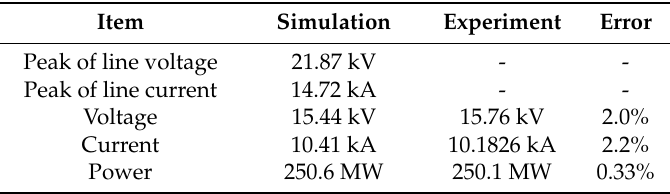
Figure 10. Improved mesh of generator model. Table 2. The results comparison between simulation and experimental tests.